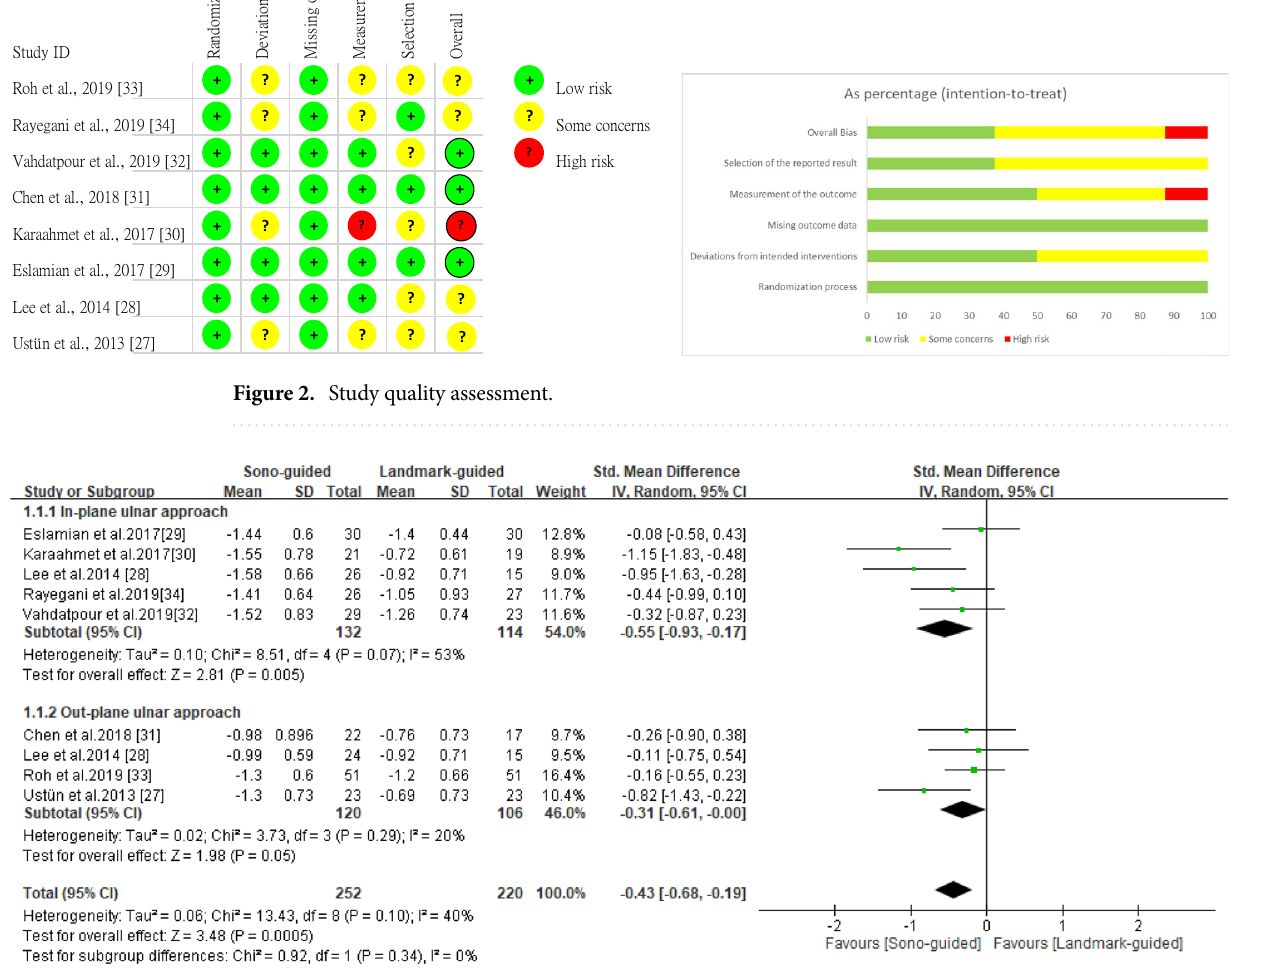
Figure 3. Forest plot for the BCTQ-SSS. US-guided, ultrasound guided; LM-guided, landmark